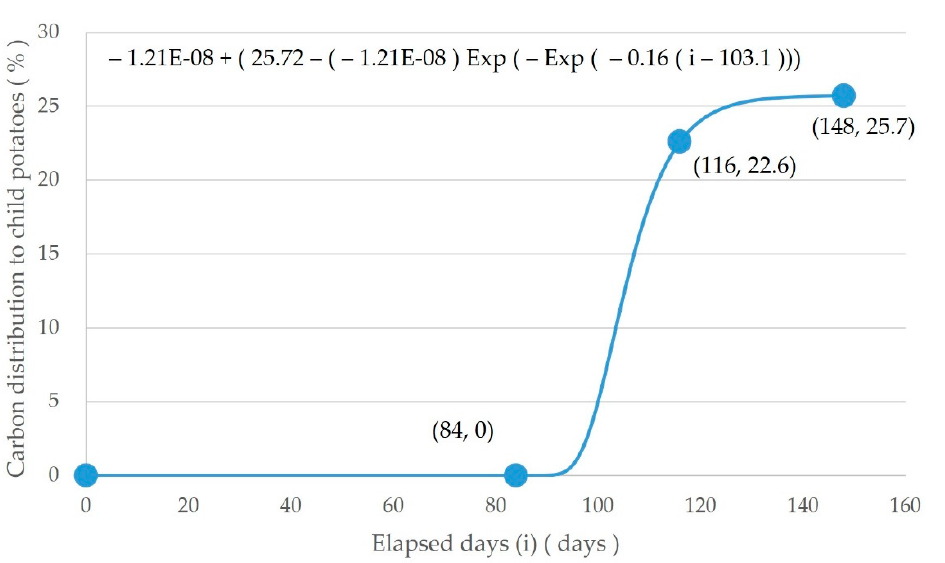
Figure 5. Carbon distribution rate to child potatoes by elapsed days ( R c ).